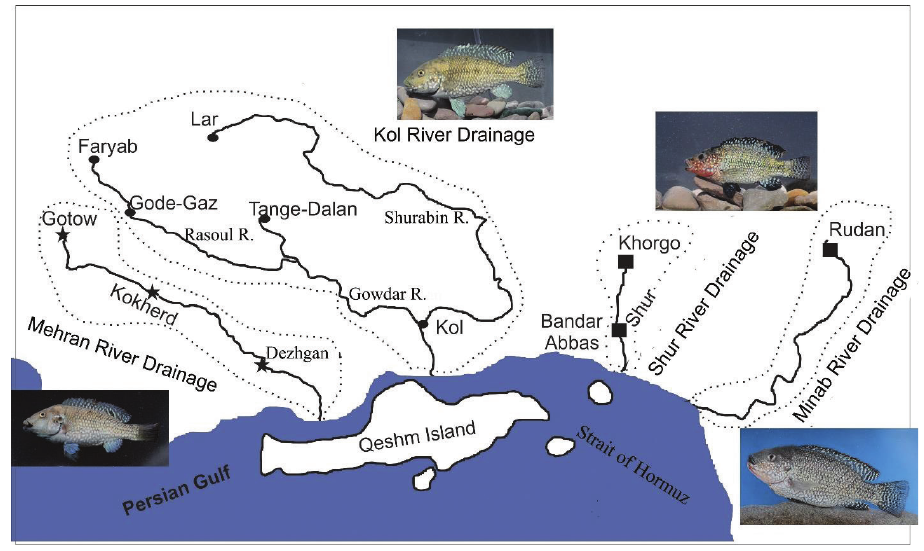
Figure 1. Geographic distribution map of Iranocichla populations in four river drainages of Iran. Symbols indicate our sampling sites and the different taxa. Asterisk = I. hormuzensis, rectangle = I. persa sp. n., circle = Iranocichla sp.